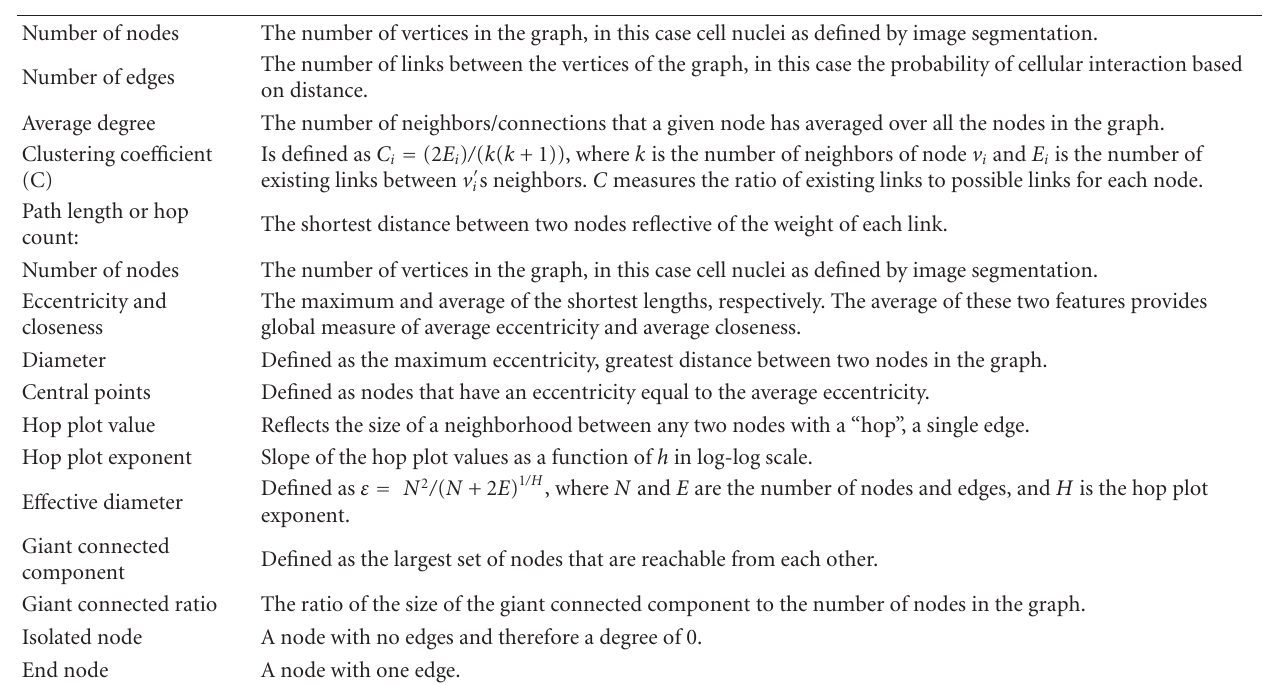
Table 1: Description of graph metrics.